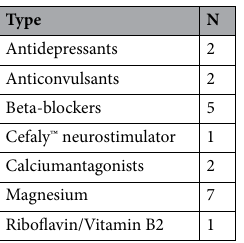
Table 2. Types and frequencies of migraine prophylactic treatments. Note that more than one type of prophylactic drug could be used.